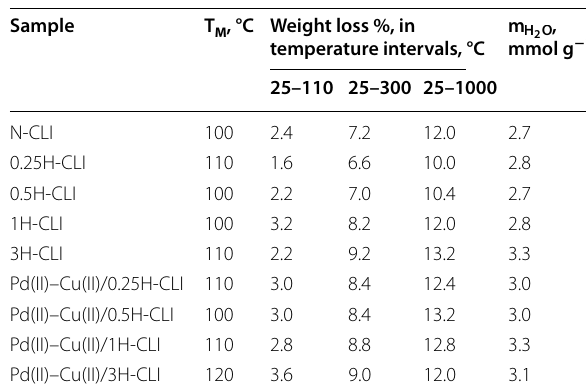
Table 3 Results of the thermogravimetric analysis of